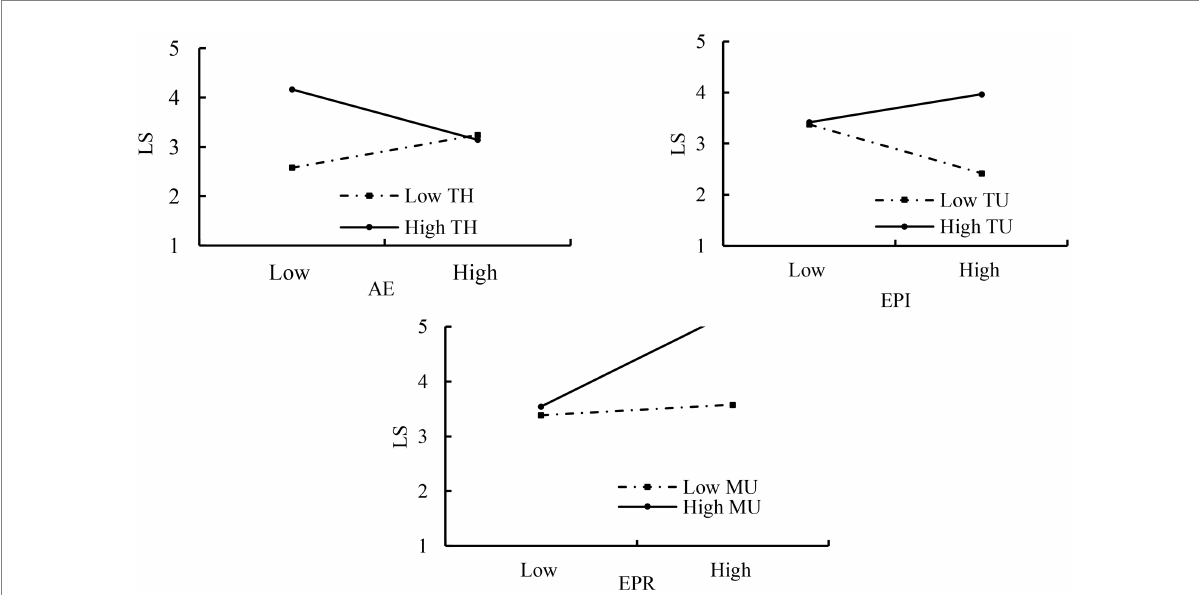
FIGURE 2 Moderating effects of entrepreneurial team heterogeneity and environmental uncertainty between improvisation and lean search. EPI, exploitative improvisation; EPR, explorative improvisation; TU, technology uncertainty; MU, market uncertainty; TH, entrepreneurial team heterogeneity; LS, lean